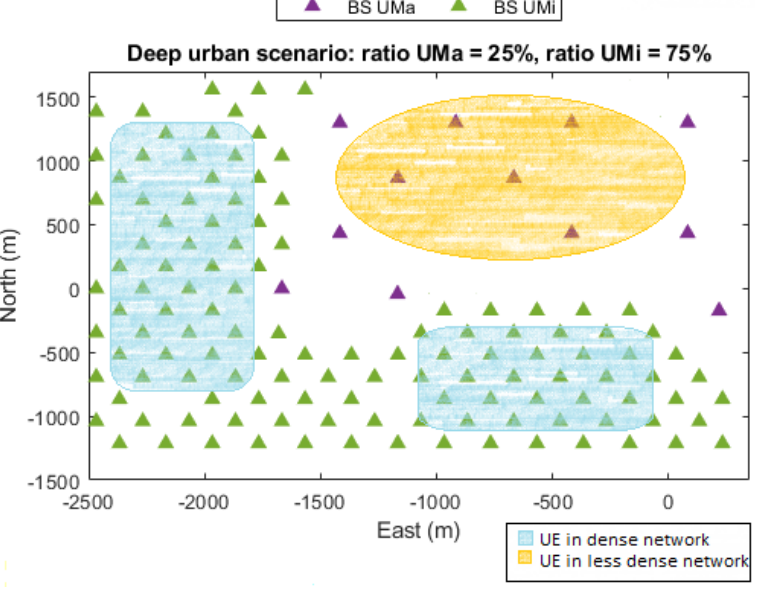
Figure 3. Simulation scenario